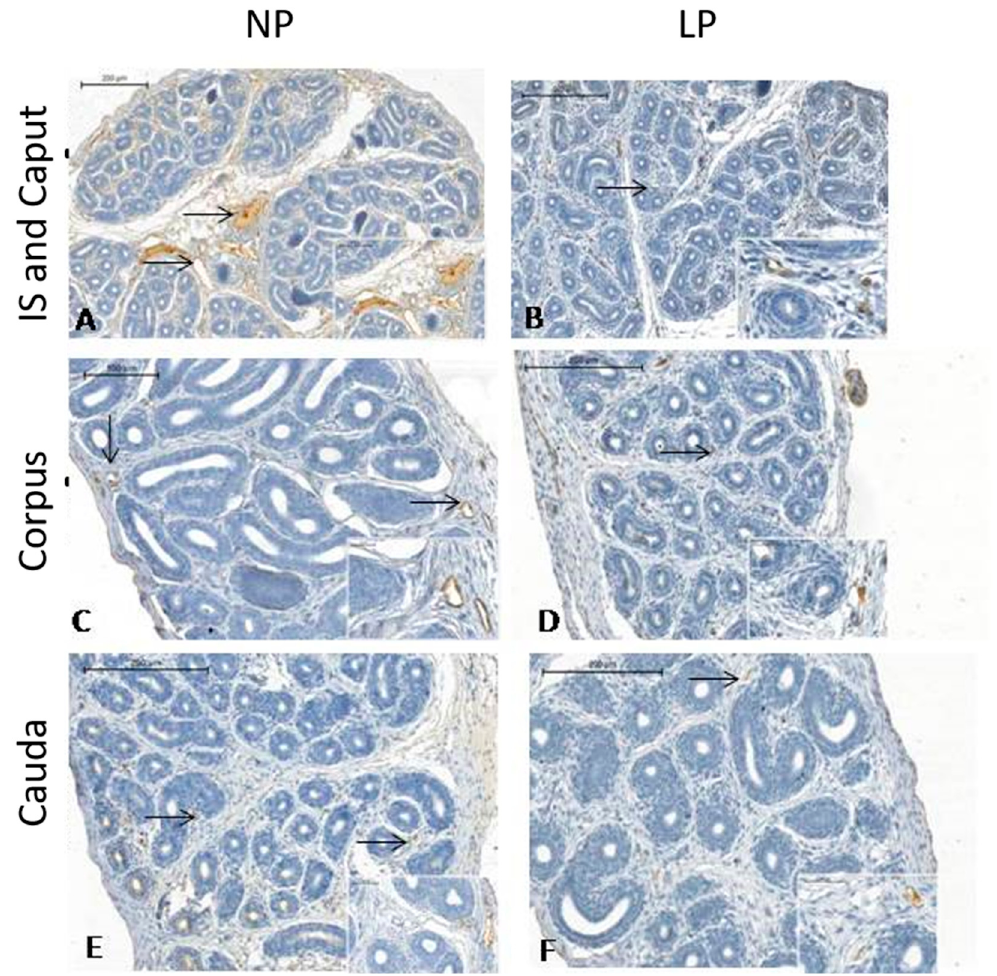
Figure 4. Epididymis sections of the initial segment (IS), caput regions, corpus and cauda from the NP and LP animals at PND14 subjected to AQP1 immunostaining. NP = normoprotein animals; LP = low-protein animals. A (IS and Caput from NP group); B (IS and Caput from LP group); C (Corpus from NP group); D (Corpus from LP group); E (Cauda from NP group); F (Cauda from LP group). Arrow = Positive staining for AQP1 in the vascular endothelium.